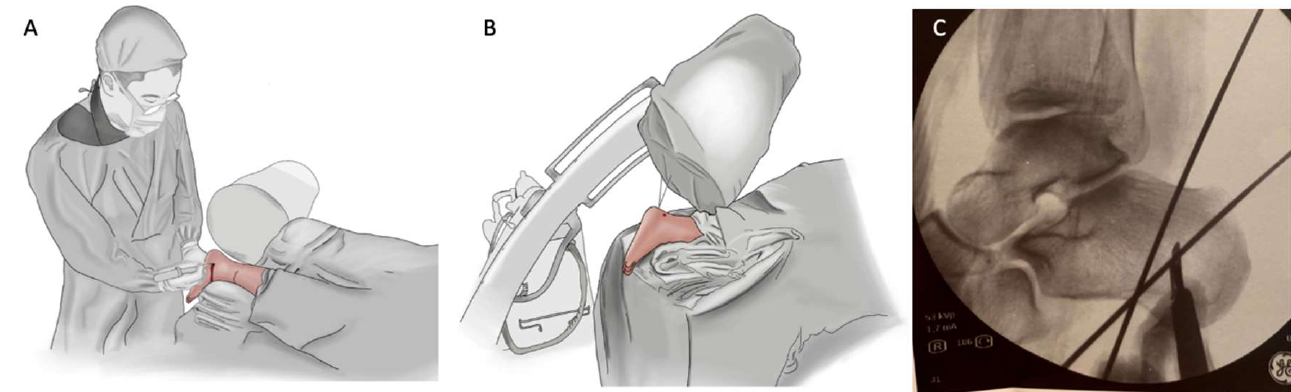
Figure 1. ( A ) The entire procedure can be performed with the patient in the prone position and C-arm position. ( B ) Two k-wires are positioned in a “v” shape, most of the proximal k-wire is placed at the limit of the “safe zone”, which is halfway between the calcaneal spur and fibula, and the position of the distal k-wire depends on the amount of correction needed. Note that the lateral calcaneal view is an oblique view of the ankle. ( C ) How k-wires are positioned in a X-ray view, showing how the "v" shape has to looks like in pratice.